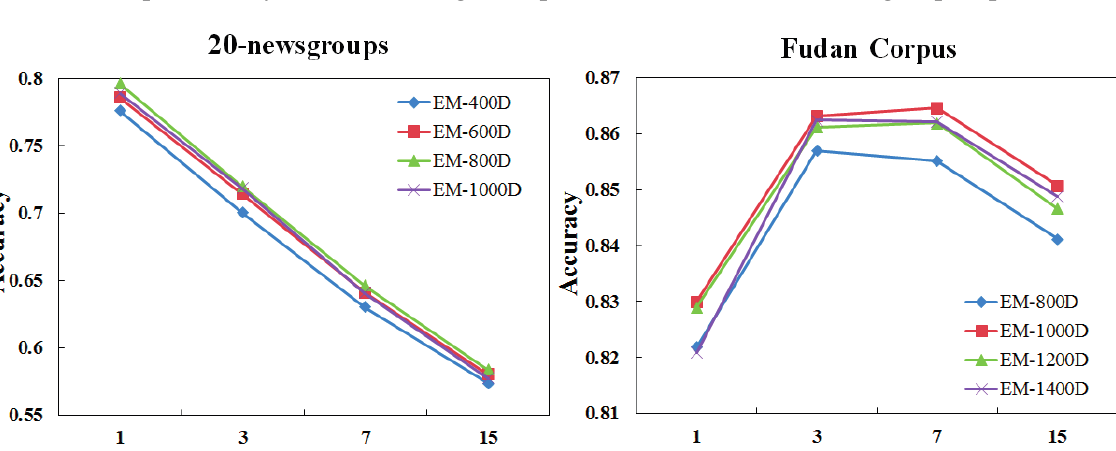
Figure 7. The fraction of retrieved documents in the same class as the query when a query document from the test set is used to retrieve other test set documents. Results are averaged over all 7531 (for 20-newsgroups) and 4948(for Fudan corpus) possible queries. The Event Model performs significantly better than LDA no matter on short documents or long documents, particularly when retrieving the top few documents on 20-newsgroups, up to 25%.